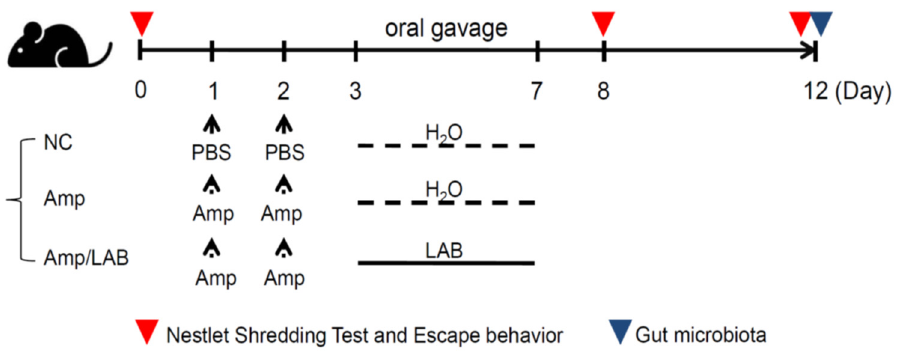
Figure 1. Experimental design of the assessment of the effects of Lactobacillus spp. on depression behaviors in C57BL/6 mice.